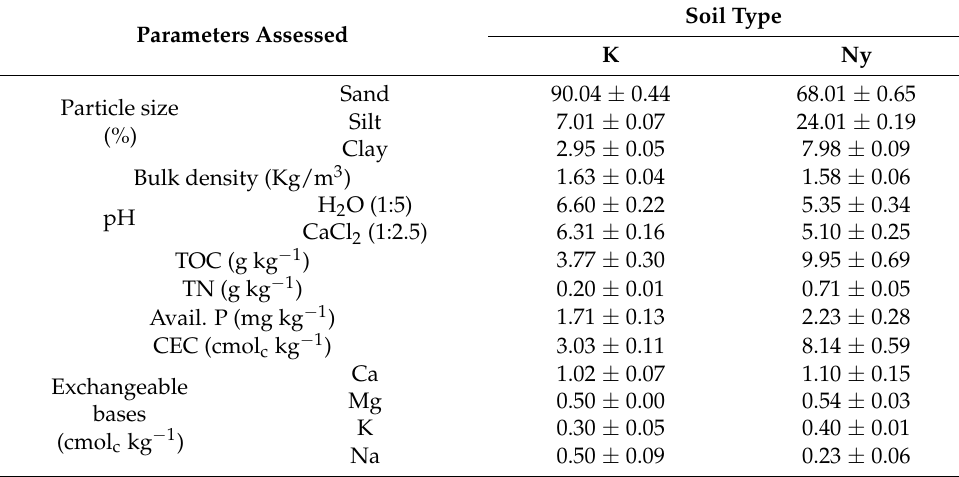
Table 1. Properties of the soils used in the